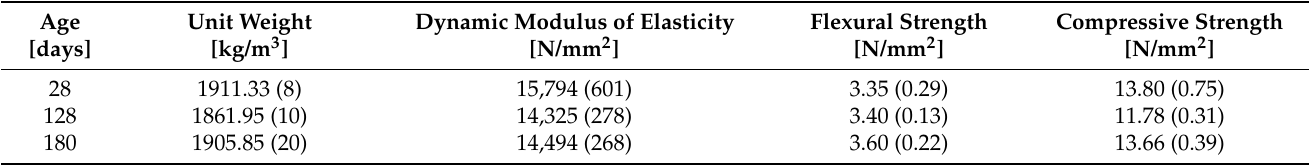
Table 3. Mean values of flexural and compressive strength test results of the bedding mortar.